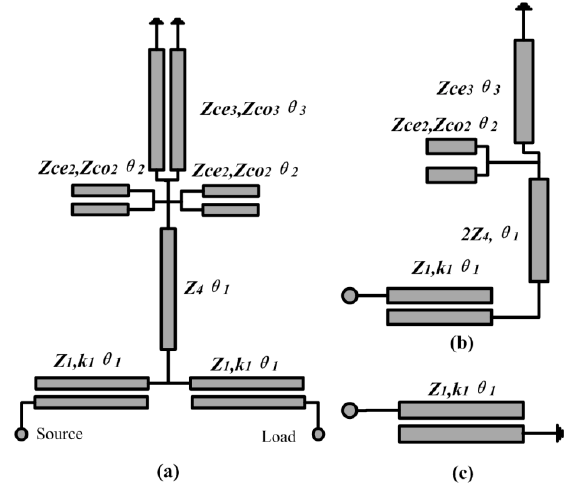
Figure 1. Ideal circuit of the CLCSR and its equivalent circuit model, ( a ) Ideal circuit model, ( b ) Even-mode circuit, ( c ) Odd-mode circuit.